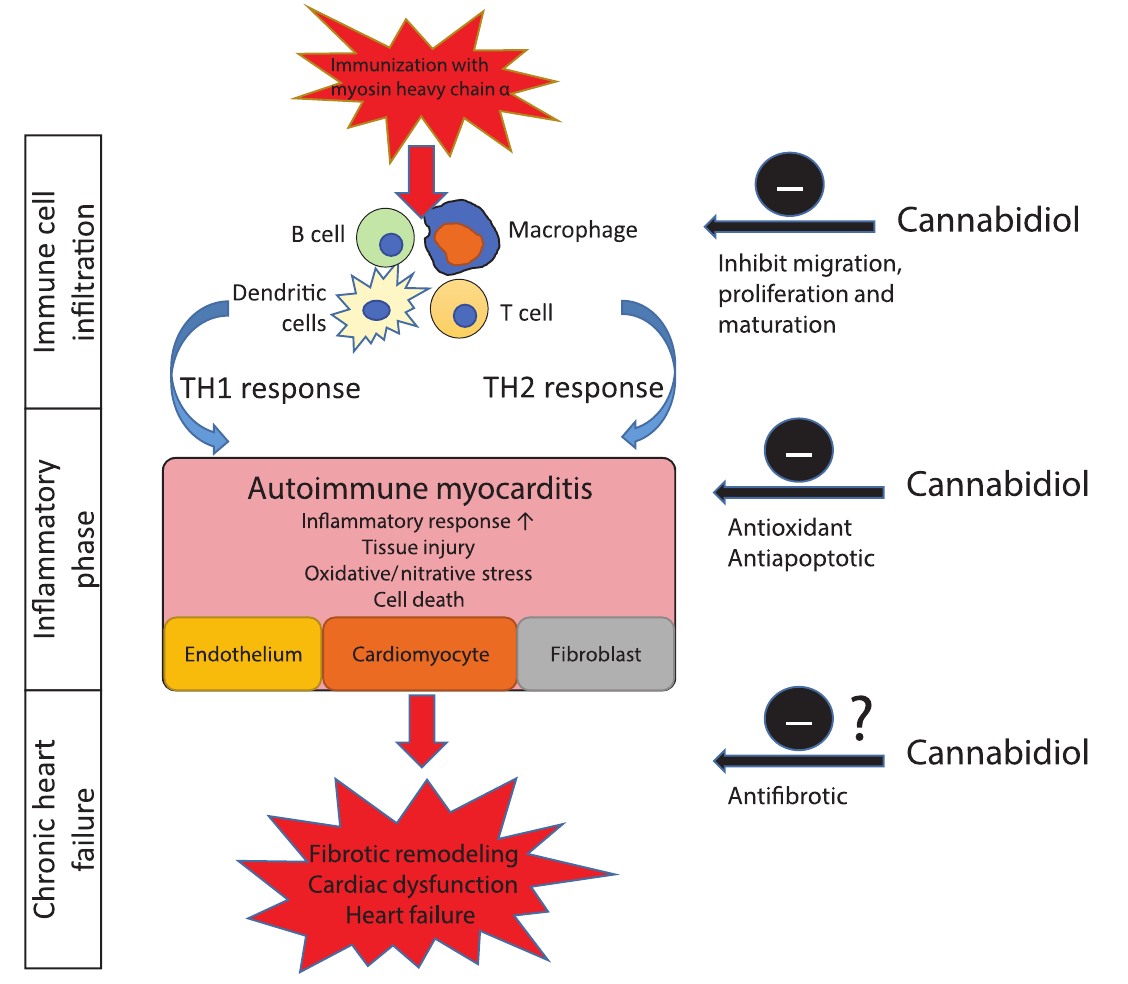
Figure 7. Summary flowchart of the effects of CBD in EAM. The schematic diagram shows the pathophysiology of EAM and the potential sites of a beneficial intervention with CBD